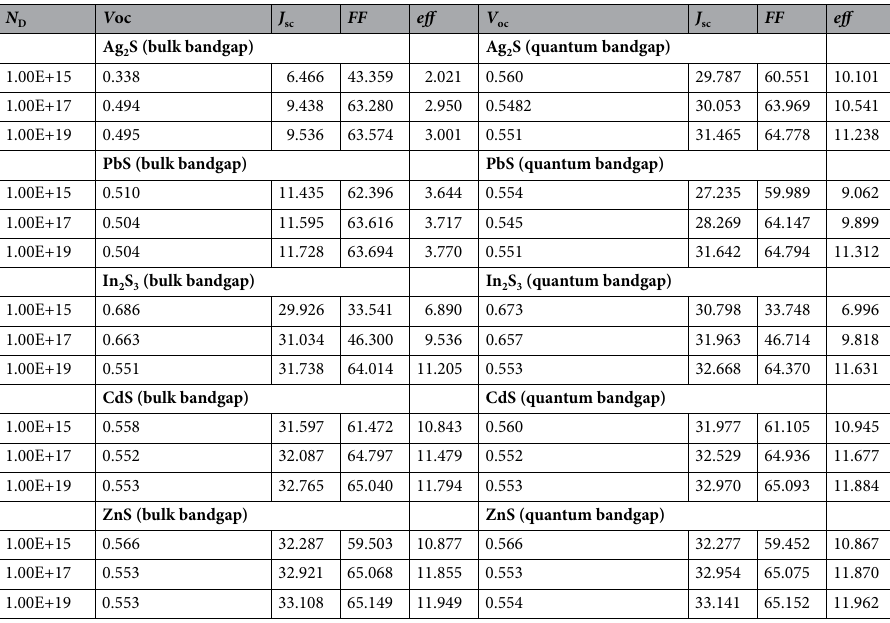
Table 4. CIGS solar cells’ photovoltaic performance characteristics at various buffer layers.